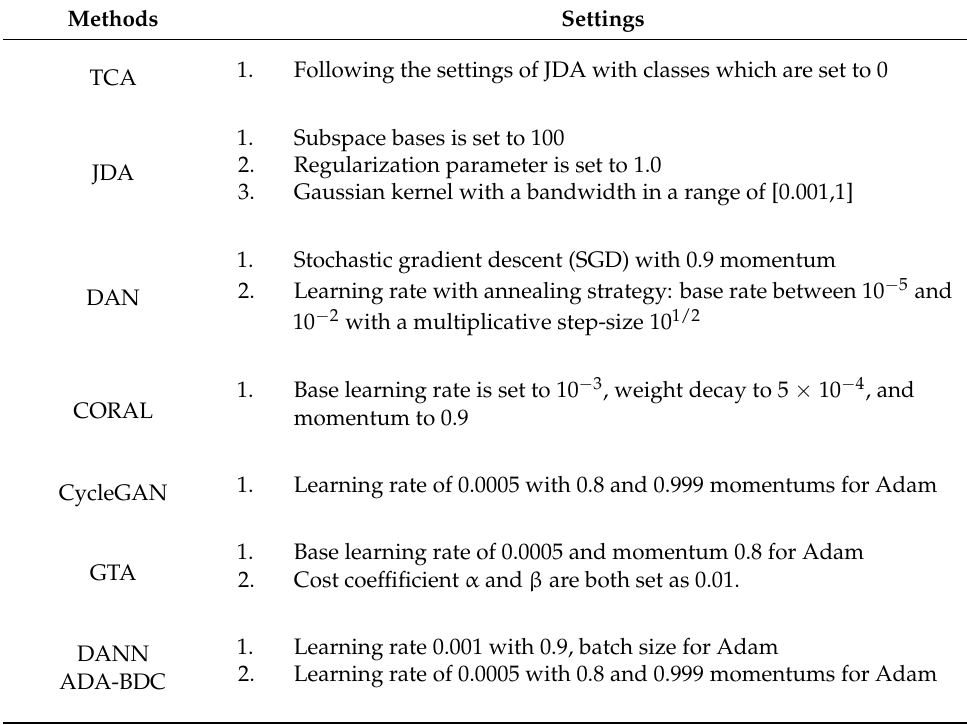
Table 3. Main hyperparameters of competitors in this work.